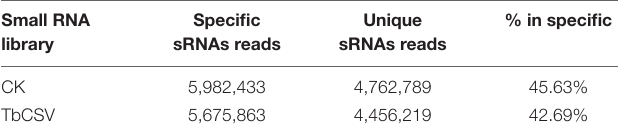
TABLE 1 | Distribution of small RNA sequences among the two constructed libraries. Small RNA